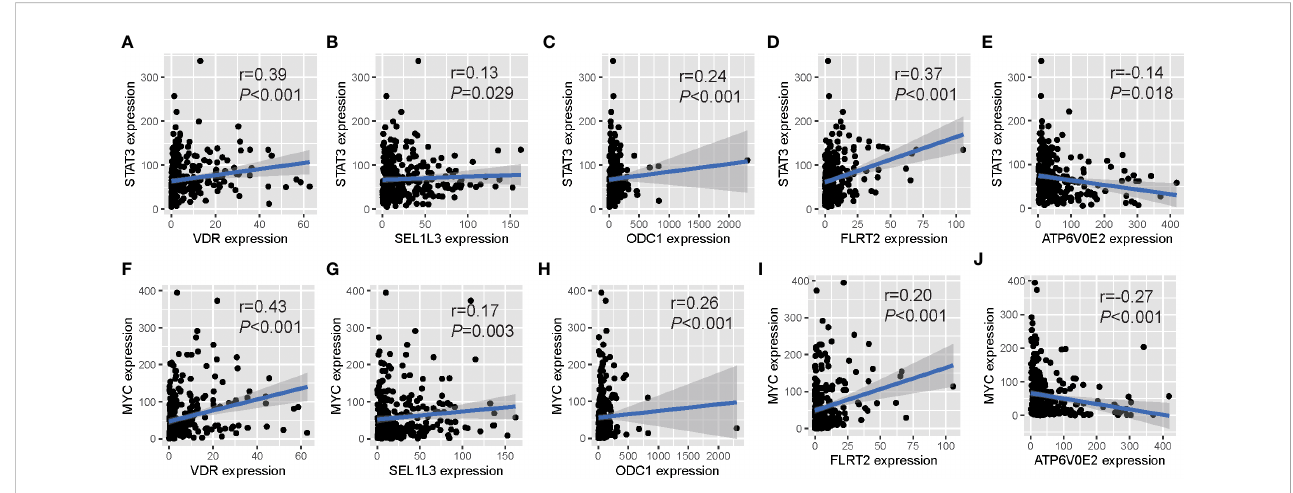
FIGURE 4 Expression relationships between prognostic OM genes and upstream TFs. Signi fi cant correlations of gene expression between fi ve prognostic OM genes and their common upstream TFs: STAT3 (A-E) and MYC (F-J) .